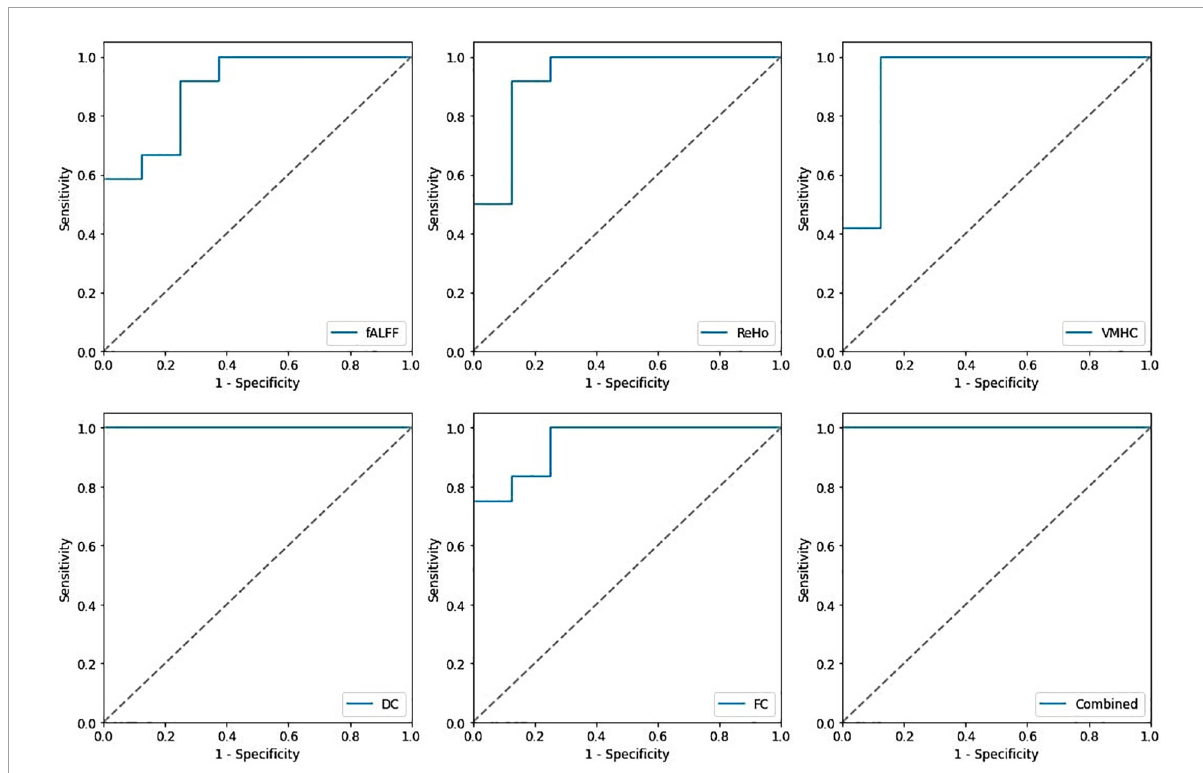
FIGURE4 Receiving operating characteristic curve (ROC) of the support vector machine (SVM) model based on the single and combined local